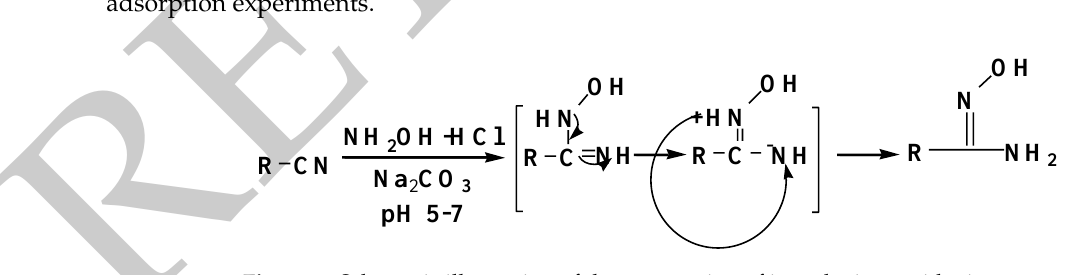
Figure 2. Schematic illustration of the preparation of introducing amidoxime group.